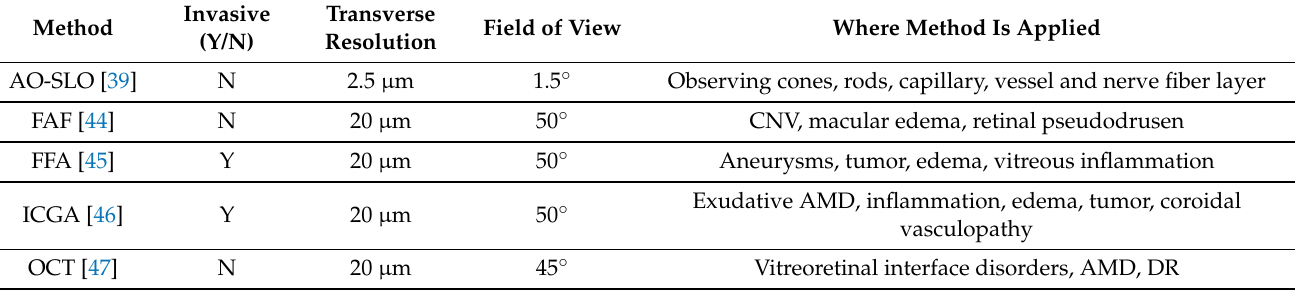
Table 1. Comparison of AO-SLO with FAF, FFA, ICGA and